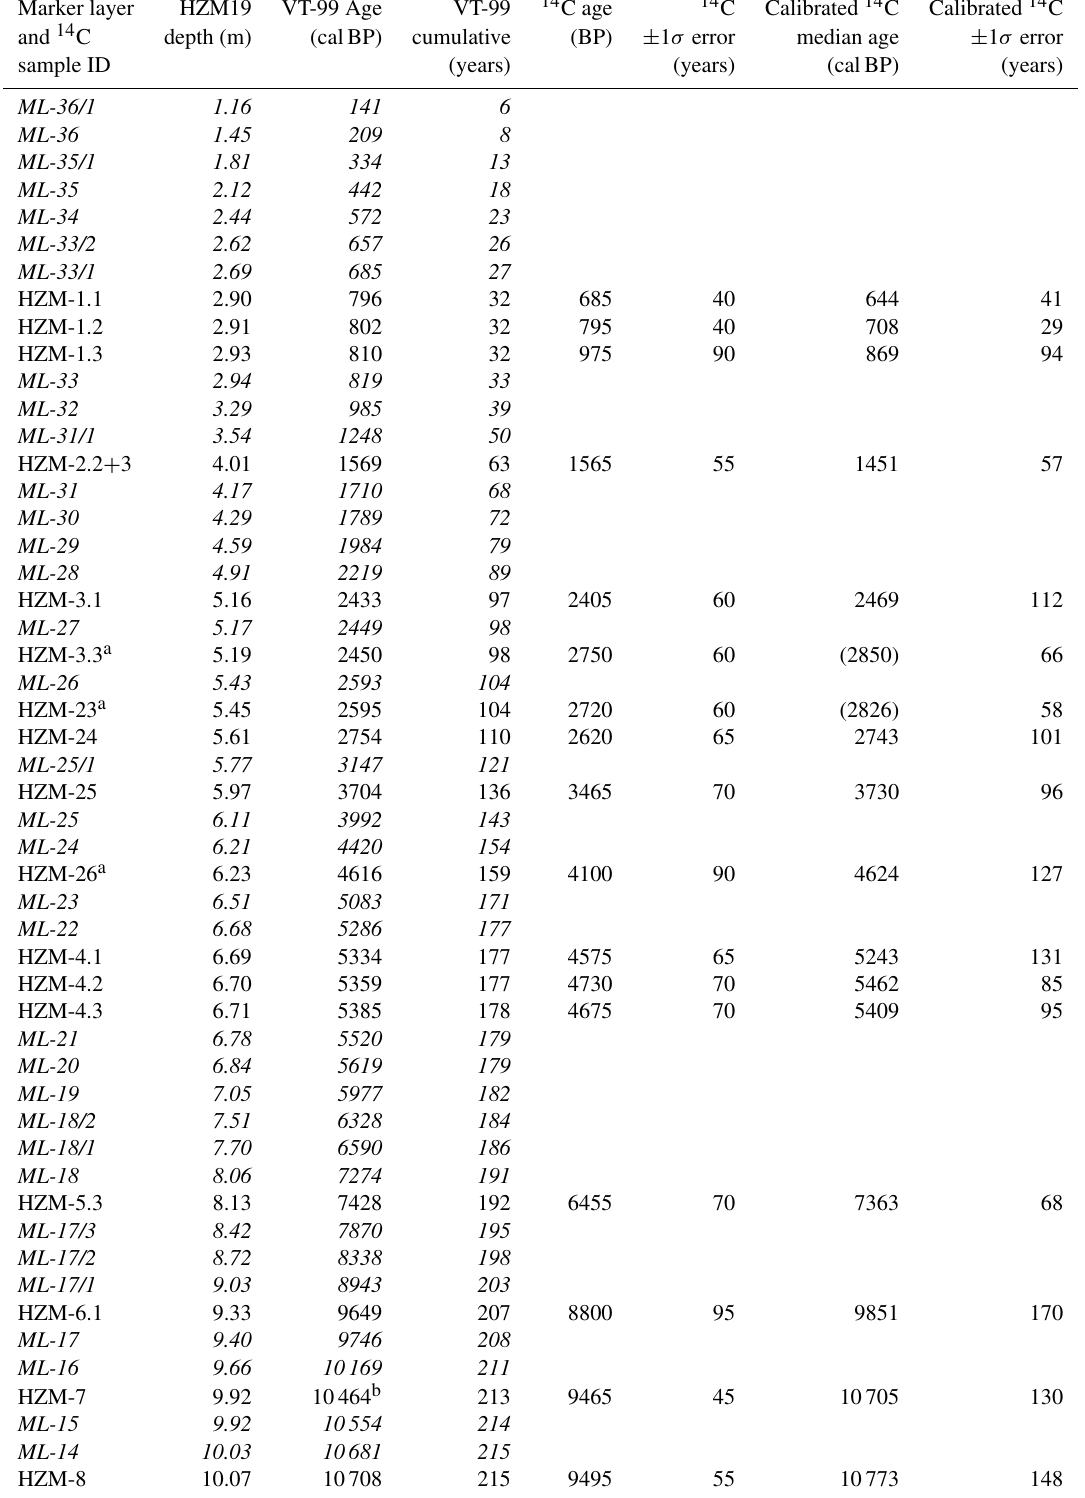
Table A5. Marker layers (in italics) and radiocarbon dates (Hajdas et al., 2000, 1995, plus one unpublished radiocarbon date) vs. composite depth of HZM19. The calibrated median 14 C age is calculated using OxCal with the IntCal20 calibration curve. Inconsistent calibrated ages are shown in